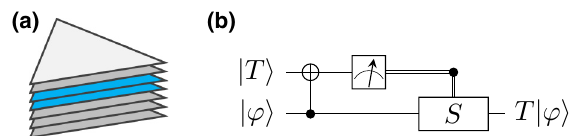
FIG. 6. (a) By stacking 2D color codes, one can implement transversal CNOT and SWAP operations between adjacent patches (colored in blue) with geometrically local gates. (b) A T state can be used to implement a T gate via gate teleportation using only Clifford